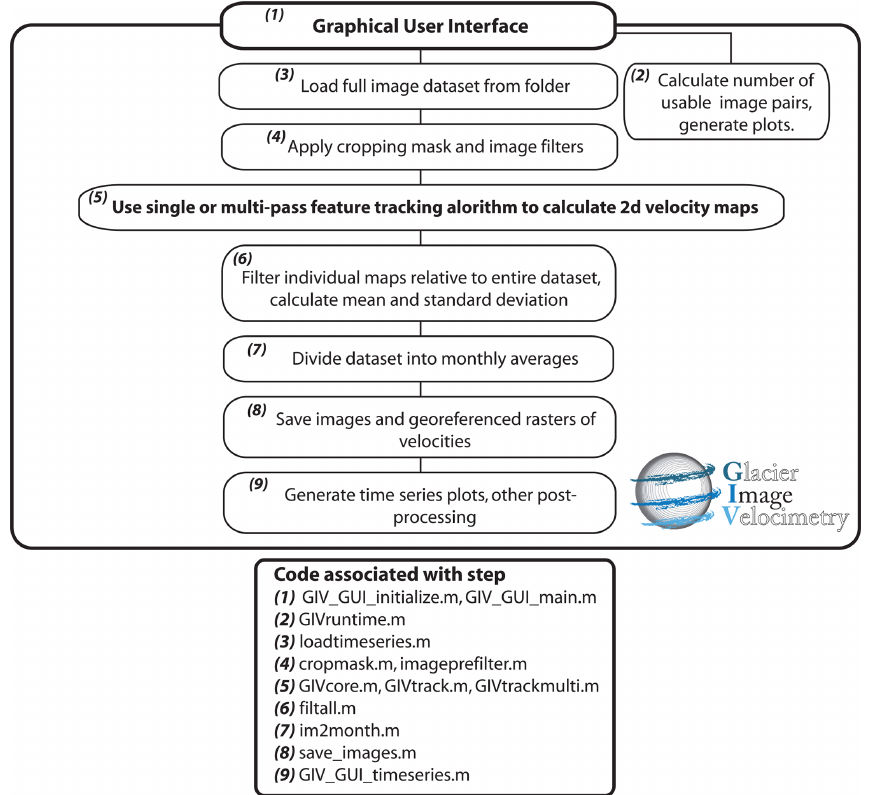
Figure 1. Flowchart describing the Glacier Image Velocimetry toolbox design. Names of the code files associated with each step are given for reference (and are available in the linked Zenodo repository). The feature-tracking step is shown in bold. Note that the source code is open source but that accessing it is not necessary for running GIV. Users may enter all parameter options into fields in the user interface, with subsequent steps automatically performed by the